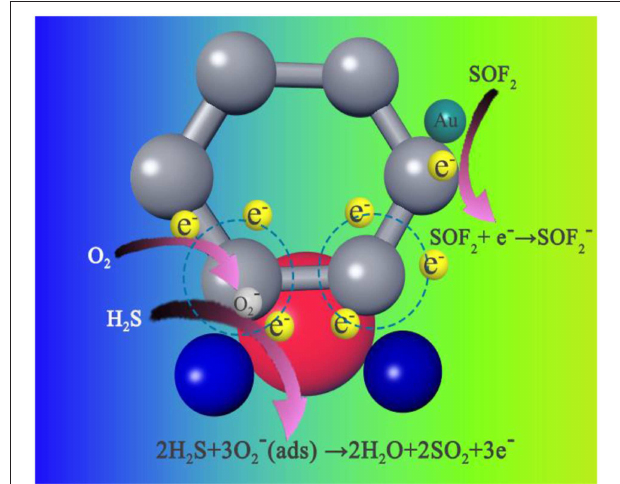
FIGURE 11 | Response values of Au-SnO 2 -rGO to 50 ppm H 2 S and SOF 2 at different relative humidity. The experiments were performed at 110 ◦ C.